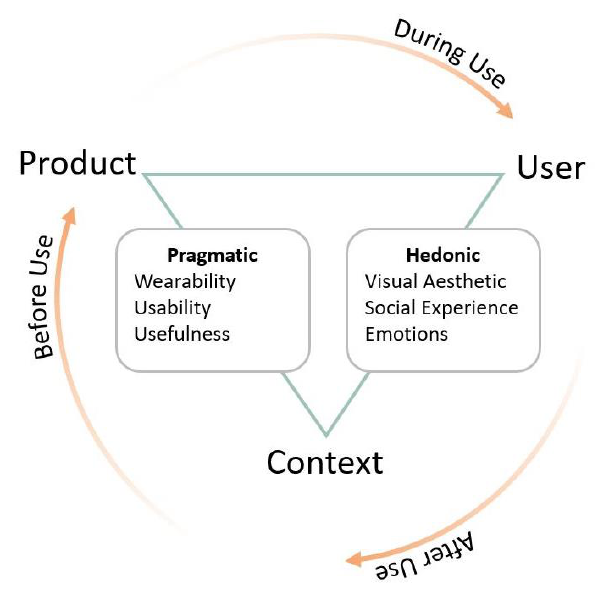
Figure 2. User-experience framework of the study.